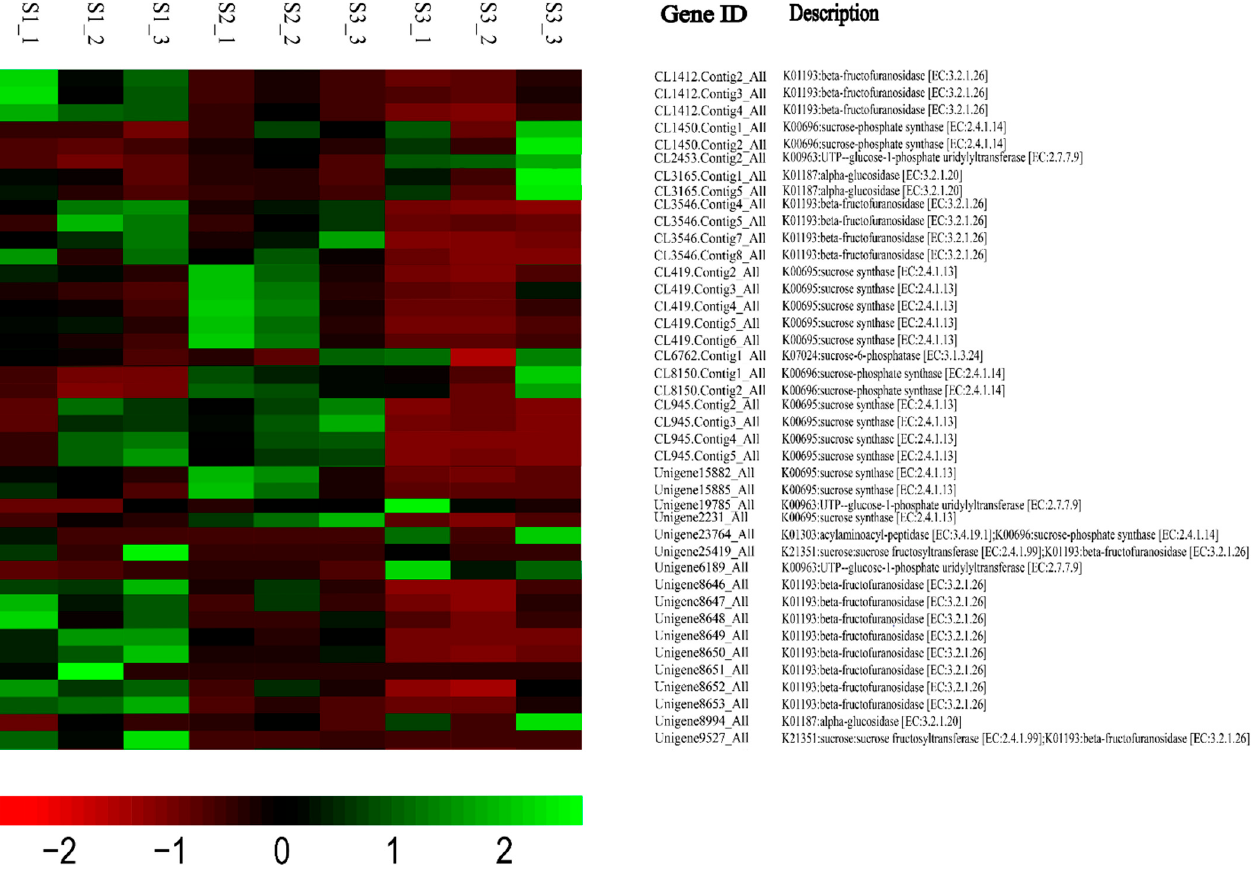
Figure 8. Heatmap of DEGs involved in starch and sucrose metabolism pathway of KEGG. Green indicates up-regulation of genes, red indicates down-regulation, and no change is indicated in black.